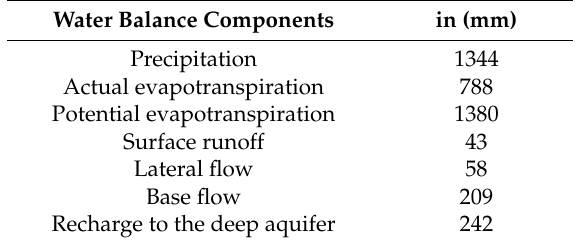
Table 6. Water balance components for the entire simulation period (1958–1970).